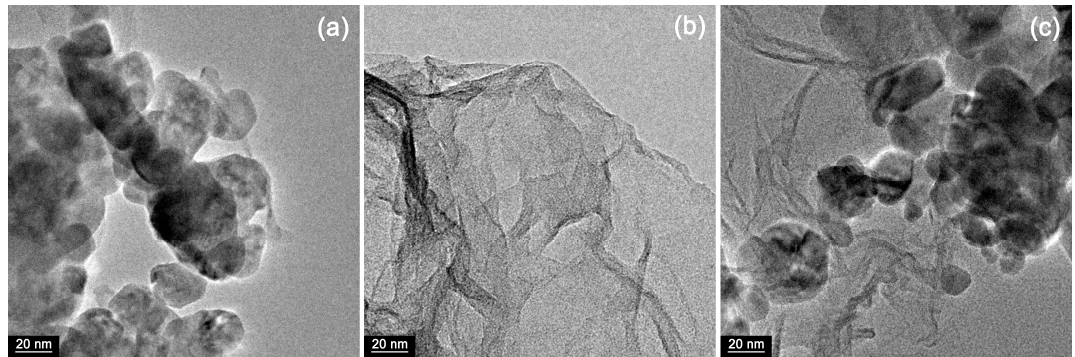
Figure 2. SEM images of ZnO nano fi bers ( a ), rGO ( b ) and ZnO/rGO nanocomposite ( c ). Figure 3. TEM images of ZnO nano fi bers ( a ), rGO ( b ) and ZnO/rGO nanocomposite ( c ).